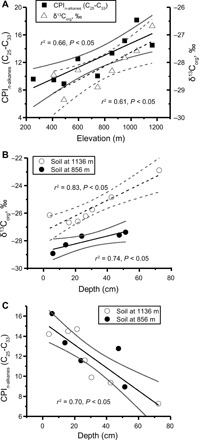
The relationship between δ13Corg and CPIn-alkanes of organic matter in soils from Mount Fox as a function of elevation and soil depth.(A) Positive linear relationship between CPIn-alkanes and δ13Corg of soil A horizons with the sampling elevation. (B) Positive linear relationship between δ13Corg and depth at two soil profiles. (C) Negative linear relationship between CPIn-alkanes and depth at two soil profiles.